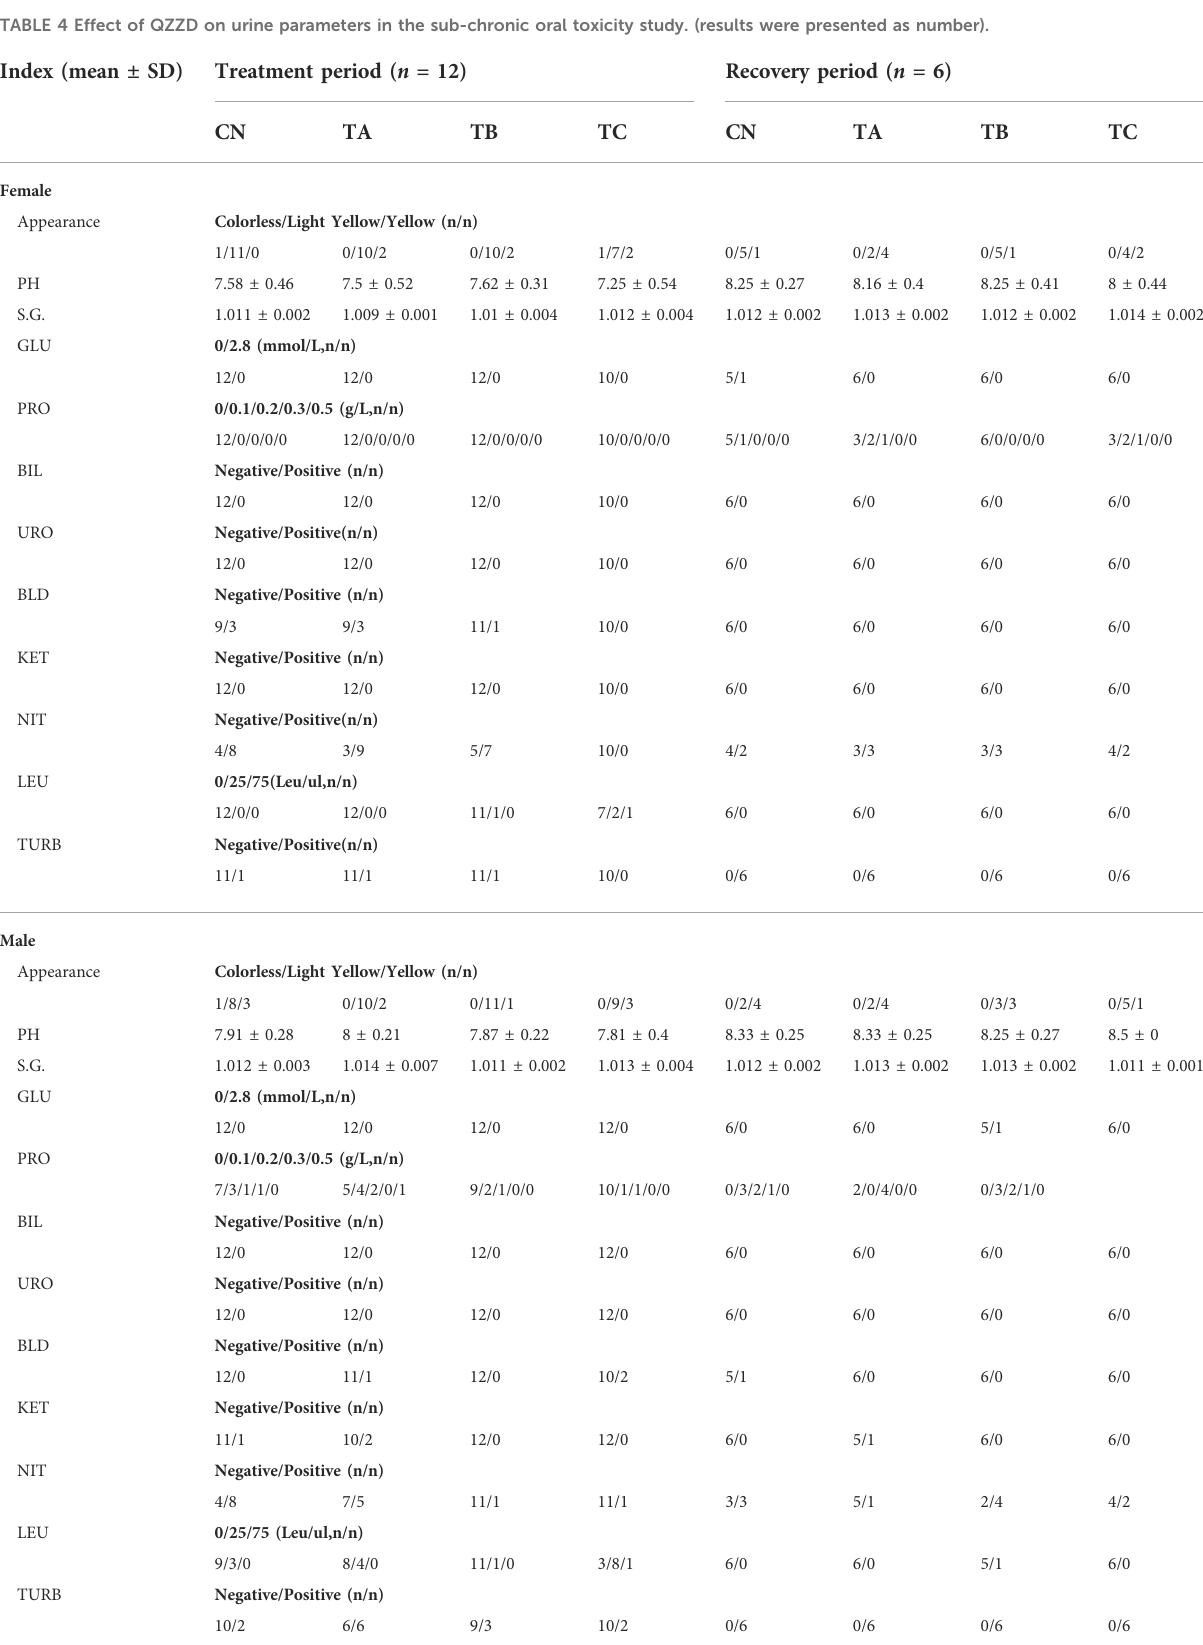
TABLE 4 Effect of QZZD on urine parameters in the sub-chronic oral toxicity study. (results were presented as